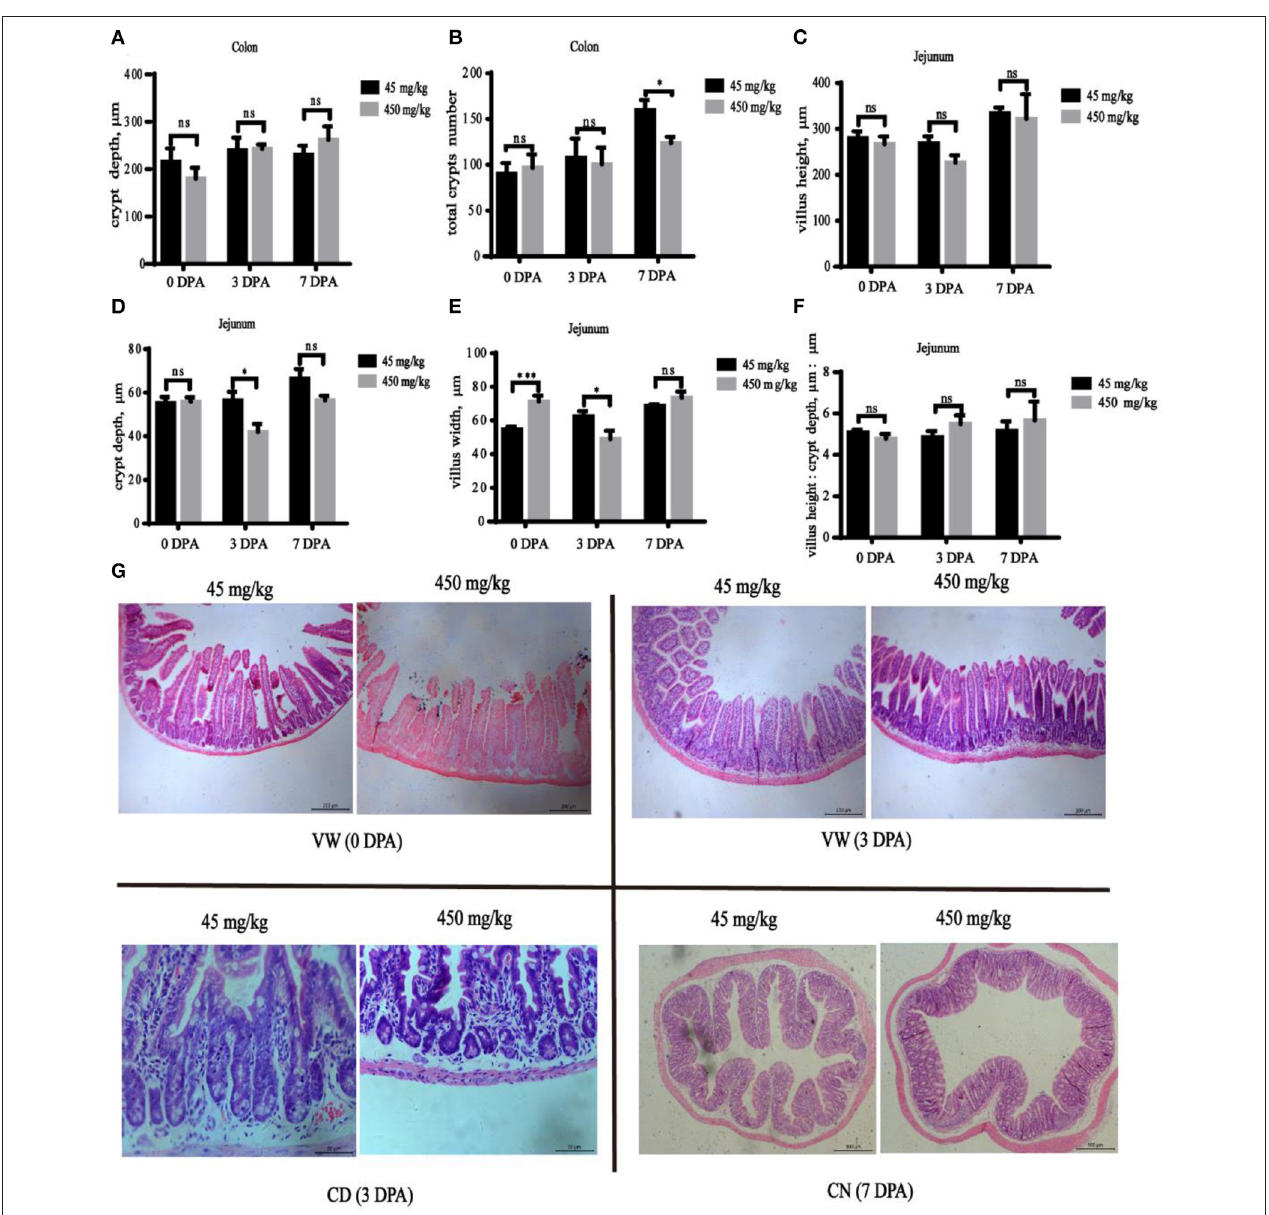
FIGURE 3 | Effects of dietary iron on jejunum and colon injury and repair in adult mice induced by DSS. The effect of high-iron diet on (A) the depth of colonic crypts, (B) the number of colonic crypts, (C) jejunum villus height, (D) jejunum crypt depth, (E) jejunum villus width, and (F) relative height of villus at 0 DPA, 3 DPA, and 7 DPA ( n = 12), ns means no significance, * indicates p < 0.05, while **indicates p < 0.01, and ***indicates p < 0.001. (G) At 0 DPA, 3 DPA, and 7 DPA, HE staining intestinal morphology images of jejunum and colon in the high-iron group and the control group. VW indicates “Villus Width,” CD indicates “Crypt Depth,” and CN indicates “Crypts Number.” 0 DPA indicates “day 0 post administration,” which is day 21 of the whole experiment cycle; 3 DPA indicates “day 3 post administration,” which is day 24 of the whole experiment cycle; 7 DPA indicates “day 7 post administration,” which is day 28 of the whole experiment cycle. Note Scale bars, VW is